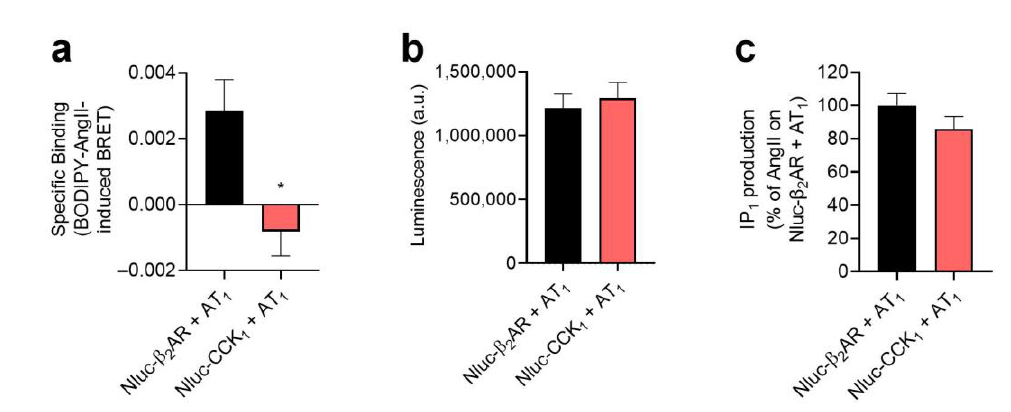
Figure 3. Lack of Receptor-Heteromer Investigation Technology (Receptor-HIT) signal between AT 1 and CCK 1 . Cells were transfected with Nluc- β 2 AR + AT 1 or Nluc-CCK 1 + AT 1 . In the NanoBRET ligand binding assay ( a ), cells were treated with 1 µ M BODIPY-AngII in the presence or absence of 1 µ M olmesartan to enable calculation of BODIPY-AngII specific binding. In the luminescence assay ( b ), raw luminescence values were obtained from untreated aliquots of cells. In the IP 1 assay ( c ), cells were treated with 1 µ M AngII. Significant differences (*) were observed in ( a ) but not ( b ) or ( c ), using unpaired t -tests. Data are displayed as mean ± SEM of three independent experiments.